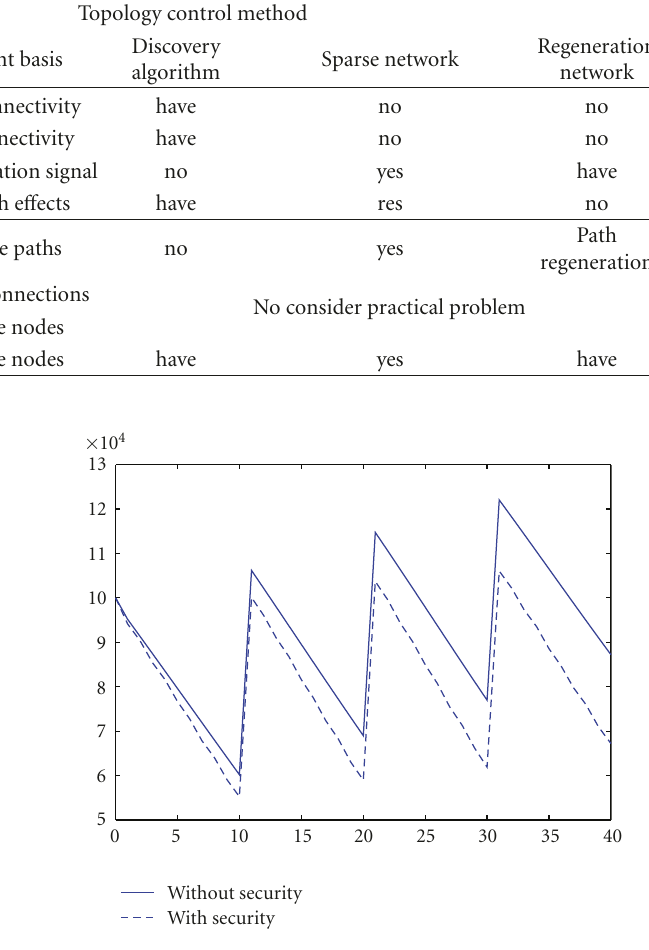
Figure 10: Regeneration for rest